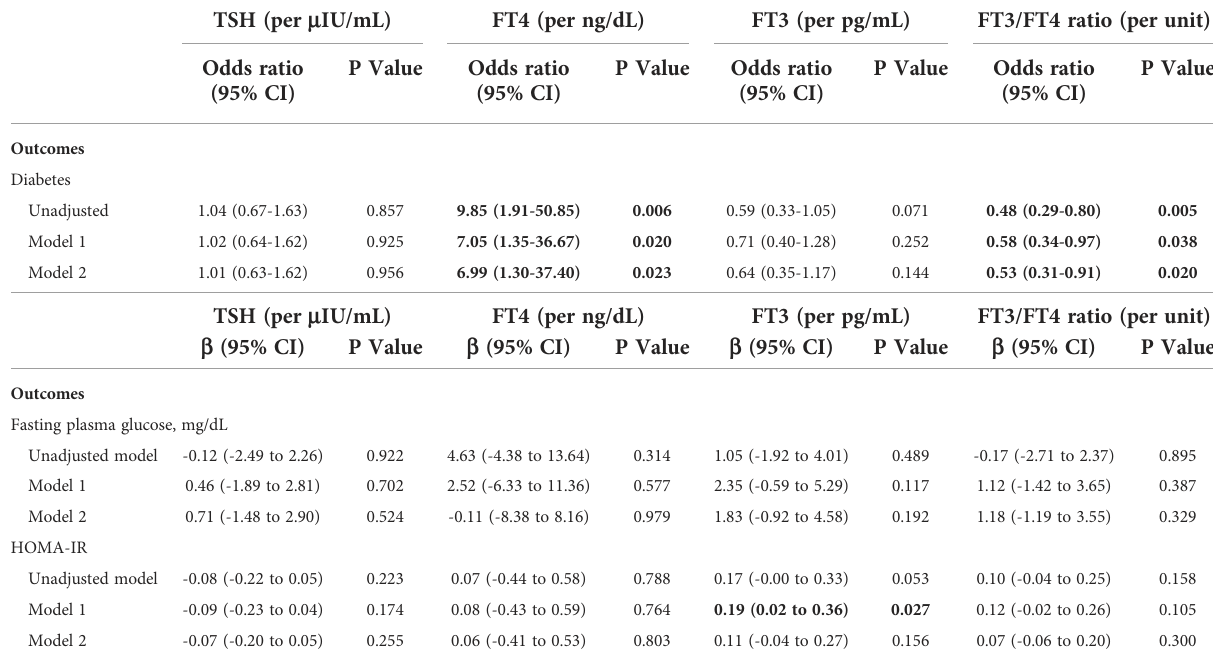
TABLE 3 Association of thyroid function with diabetes and glucose pro fi